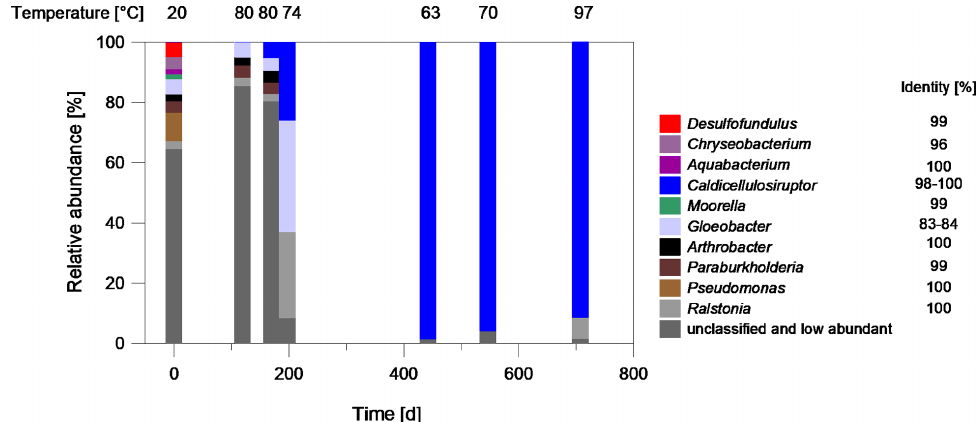
Figure 8. Characterization of the bacterial biocenosis of fluid samples from the plant exit at the geothermal plant Unterhaching since August 2017. The samples have been taken over a period of about 700d since inhibitor dosage. Blue: fermentative bacteria, Red sulfate- reducing bacteria. The temperature at the time of sampling is denoted. The sequence identity of the best database hits is given on the right of the genus name (Microbiome